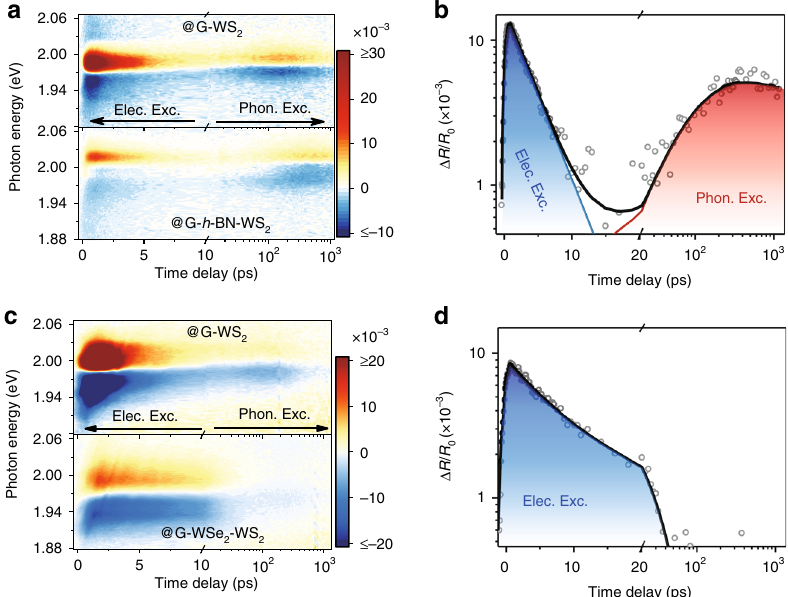
Fig. 3 Tuning of the APR process by inserting spacers. a 2D pseudo-colour TA maps of the G/WS 2 -based heterostructure with (bottom, G- h -BN-WS 2 ) and without (top, G-WS 2 ) h -BN spacer. The data for G-WS 2 are extracted from Fig. 1d. ( b ) Photocarrier relaxation dynamics measured in the heterostructure with the h -BN spacer. Dots are experimental results extracted from a , while solid lines are the results calculated using the APR model, with the electronic (phononic) excitation component labelled by the blue (red) area. c , d Same data as in a , b but measured in heterostructures with and without WSe 2 spacer. The phononic excitation completely disappears in the heterostructure with a WSe 2 spacer due to its poor thermal transport property. The upper (lower) panel is measured from Sample 1 (2).